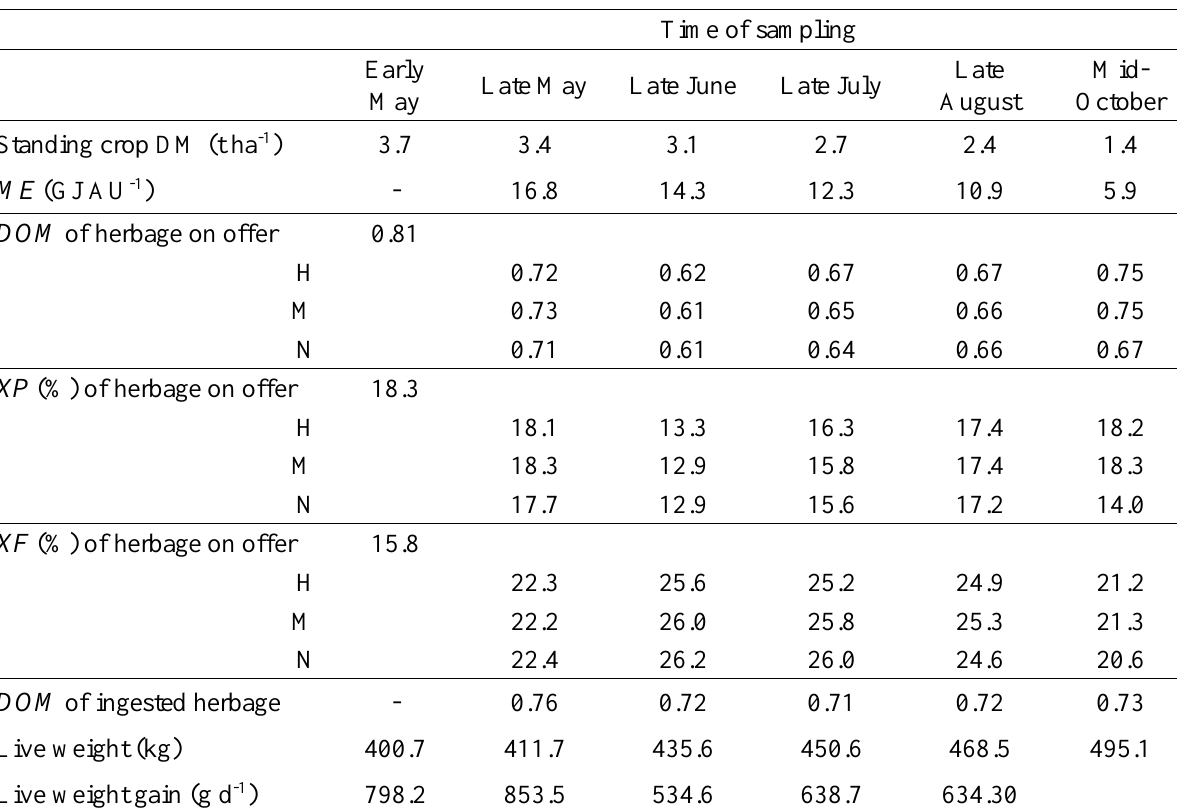
Table 1. Standing herbage biomass (dry matter, DM), metabolisable energy ( ME ) on offer per animal unit (AU), average digestibility of organic dry matter ( DOM ), crude protein ( XP ) and crude fibre ( XF ) content of herbage on offer in the heavily (H), moderately (M) and non-grazed (N) patches of the palatable pasture area; average digestibility of organic dry matter ( DOM ) of ingested herbage and average live weight per animal at individual sampling dates; average daily live weight gain for the period between the sampling date indicated in the column head and the subsequent one. Data shown were obtained before turnout (Early May) and during the grazing period (other dates) of the second year of the study